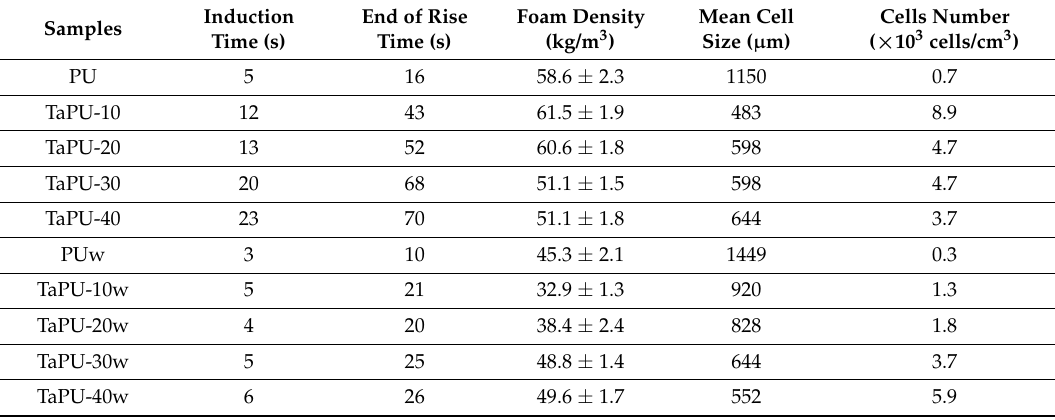
Figure 2. Kinetics curves of PU, TaPU-10, TaPU-30, and TaPU-30w foams: ( A ) height vs. time, ( B ) dielectric polarization vs. time (inset: Temperature vs. Time). Table 2. Characteristic times during the foaming process and the density of final foams.